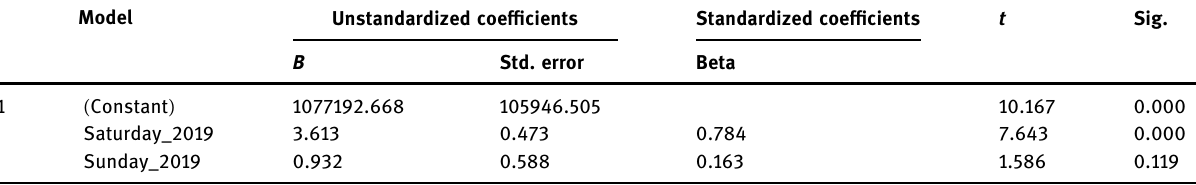
Table 5: Coe ffi cients for weekends Unstandardized coe ffi cients Standardized coe ffi